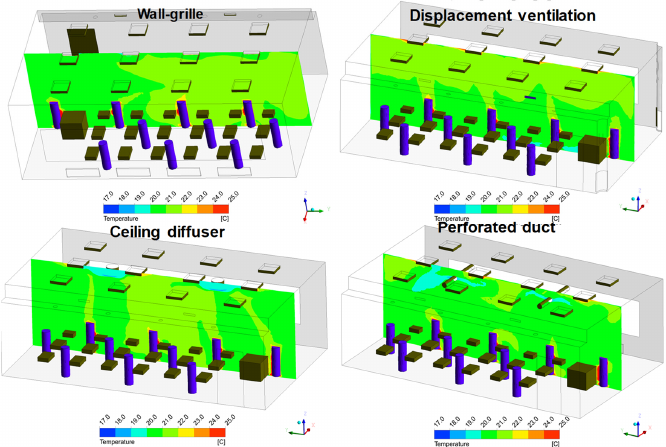
Figure 11. Air temperature in the middle cross-section plane of classroom in winter.